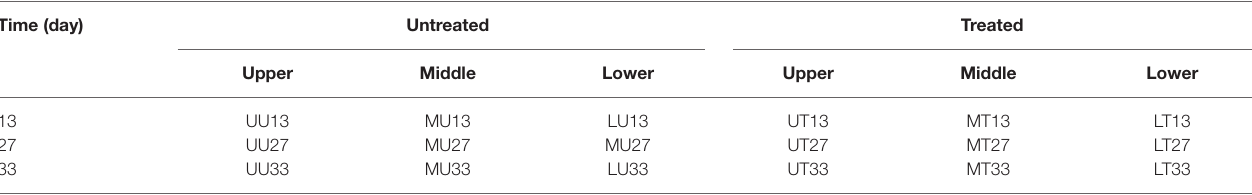
TABLE 1 | The 18 different GIT section-treated/untreated-sampling time combinations in this study. Time (day) Untreated